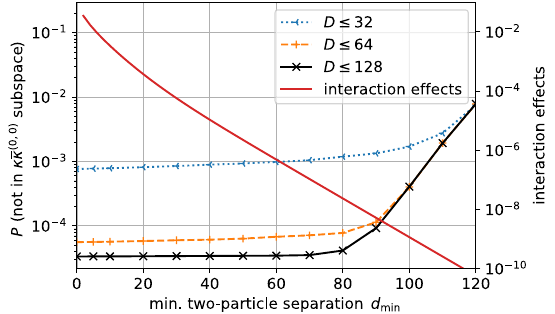
FIG. 18. Portion of the evolved bubble wavefunction outside of the kink-antikink “sector” for simulation (i) of Fig. 7 ( λ = 0, g = 0.8, h = 0.007) at time t = 240, as a function of the minimum separation d min : = min ( k − j ) permitted in the two- (cid:3) . Probabilities are computed via quasiparticle basis states | κκ ( 0,0 ) j , k a Fourier analysis, taking into account the momentum depen- dence of the basis states. The basis error due to interaction effects is estimated using Eq. (C22).